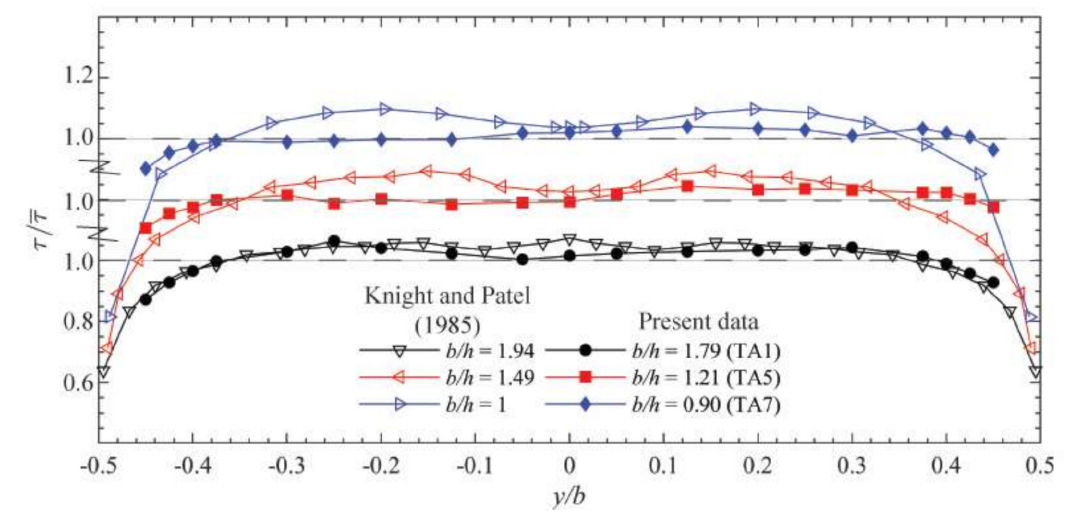
Figure 15. Comparison of duct and open channel flows: bed shear stress distributions across the